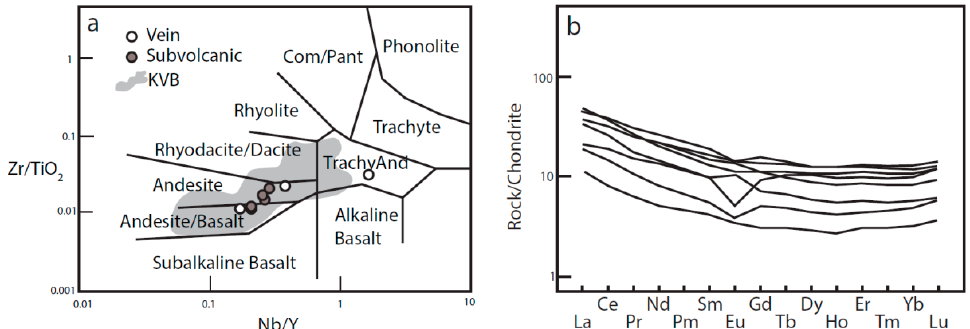
Figure 5. ( a ) Plots of Zr/TiO 2 vs. Nb/Y values of Busang subvolcanic rocks following the diagram of Winchester and Floyd [22]. Also shown is the geochemical trend of volcanic rocks that host the epithermal deposits along the ECKVB (Figure 1; data from Soeria-Atmadja et al. [14]), ( b ) Chondrite-normalized rare earth element (REE) patterns of the Busang samples. The normalizing values are from Sun and McDonough [26].